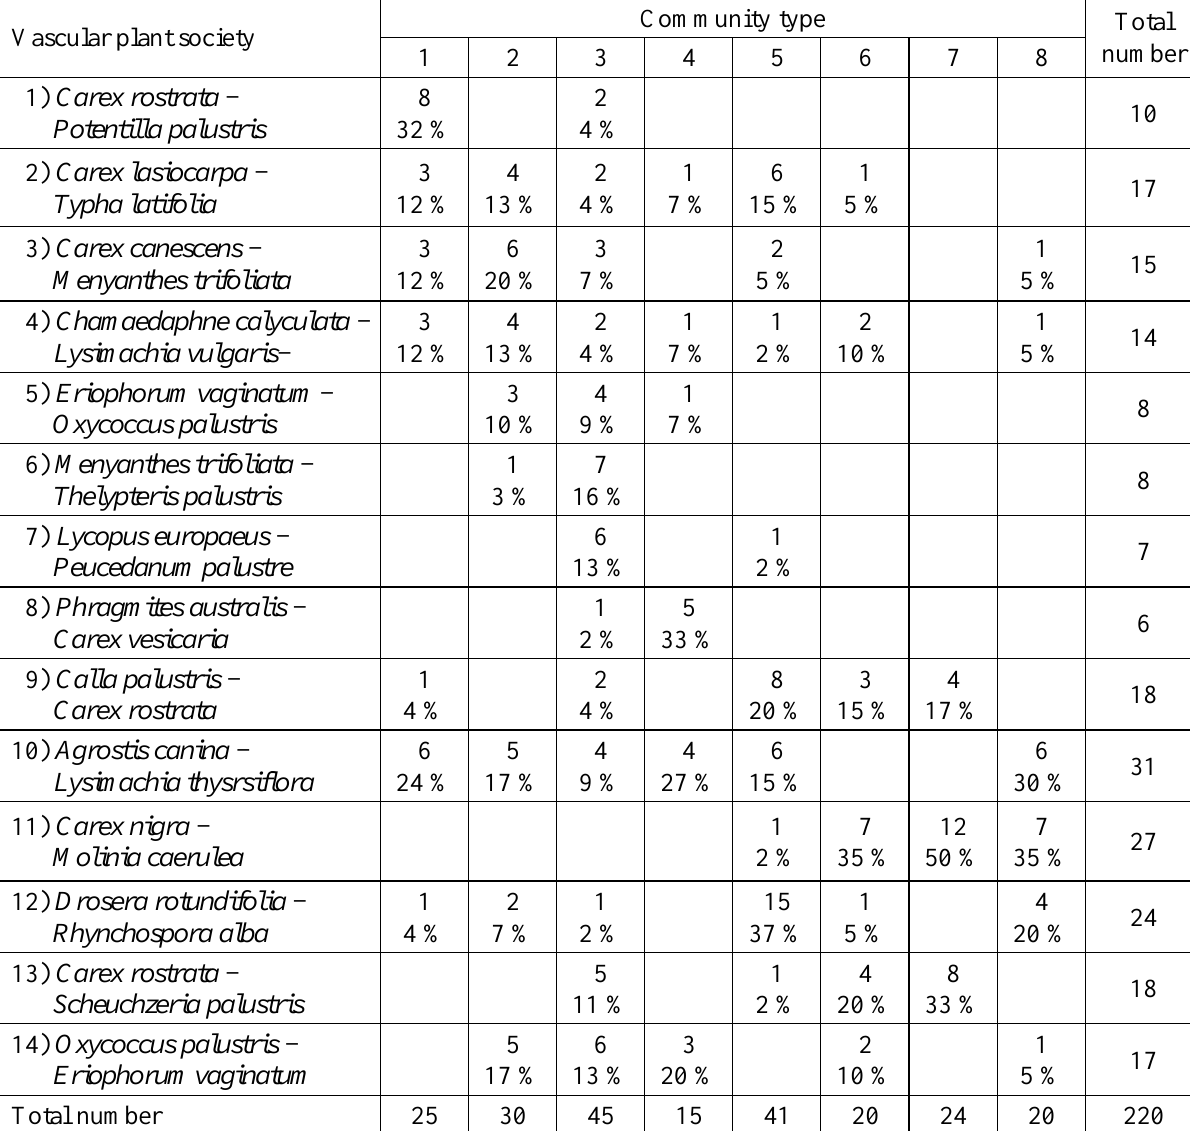
Table 10. Cross-tabulation of community types and vascular plant societies (number and percentage of their